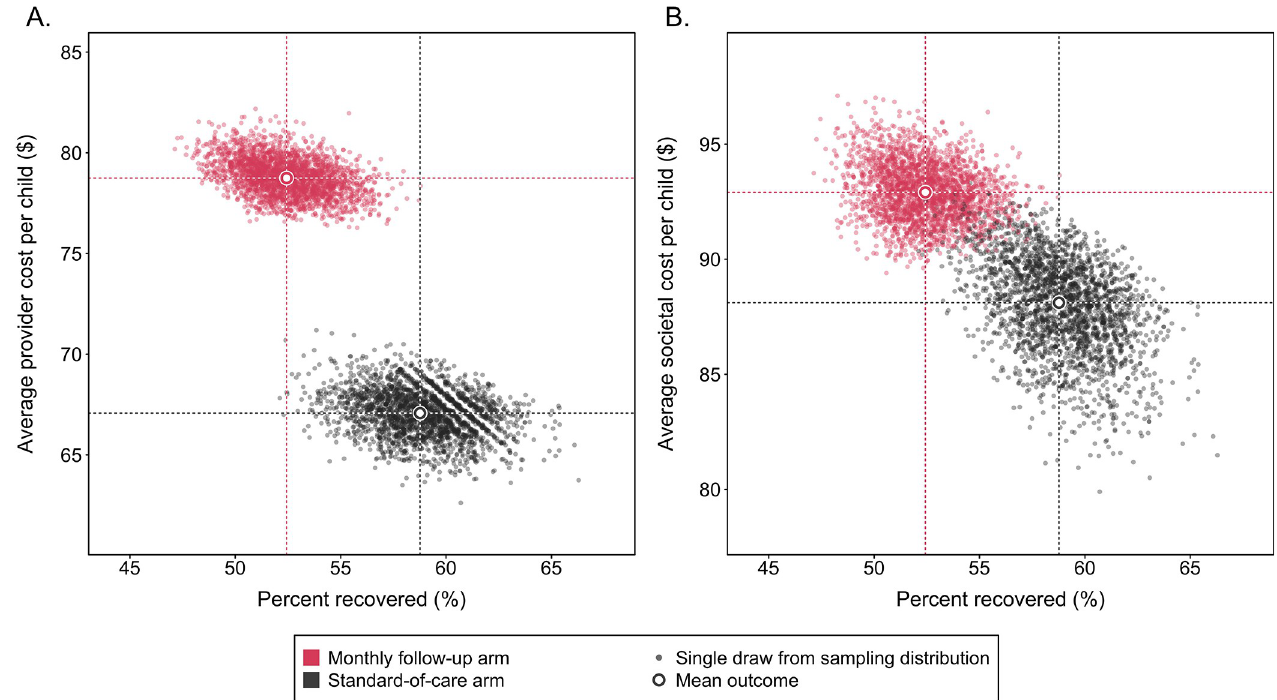
Fig 2. Per child costs and probability of achieving nutritional recovery under standard-of-care and monthly follow-up arms, from provider (Panel A) and societal (Panel B) perspectives.